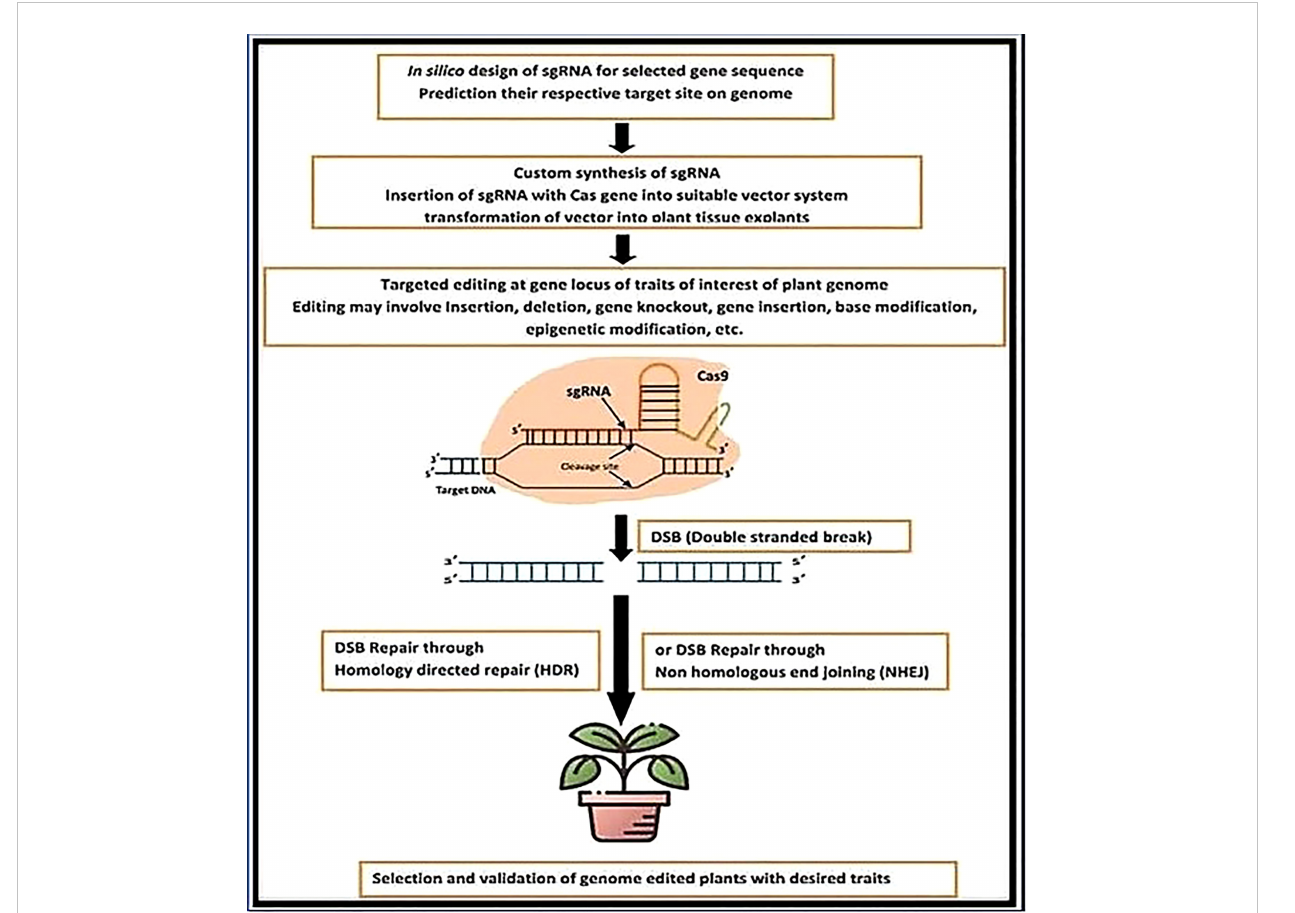
FIGURE 2 CRISPR-Cas genome editing methodology for developing genetically edited